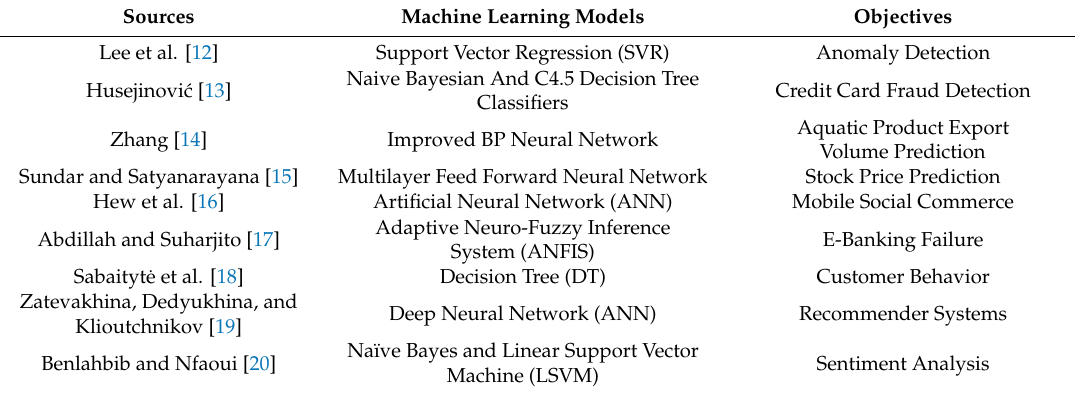
Table 1. Examples of notable classic machine learning methods applied in economics-related